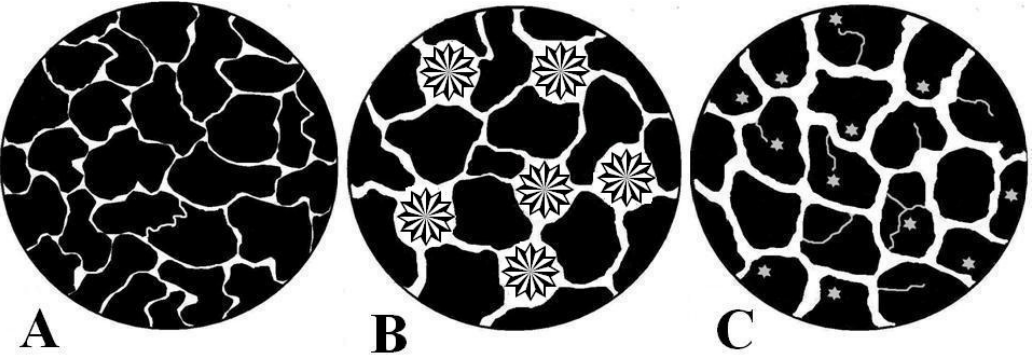
Figure 3. Schematic representation of the microstructure for DF-CS discs prepared by KN ( A ), PM ( B ) and CO ( C ). DF form II agglomerates ( ). DF form III dispersed crystals ( ).